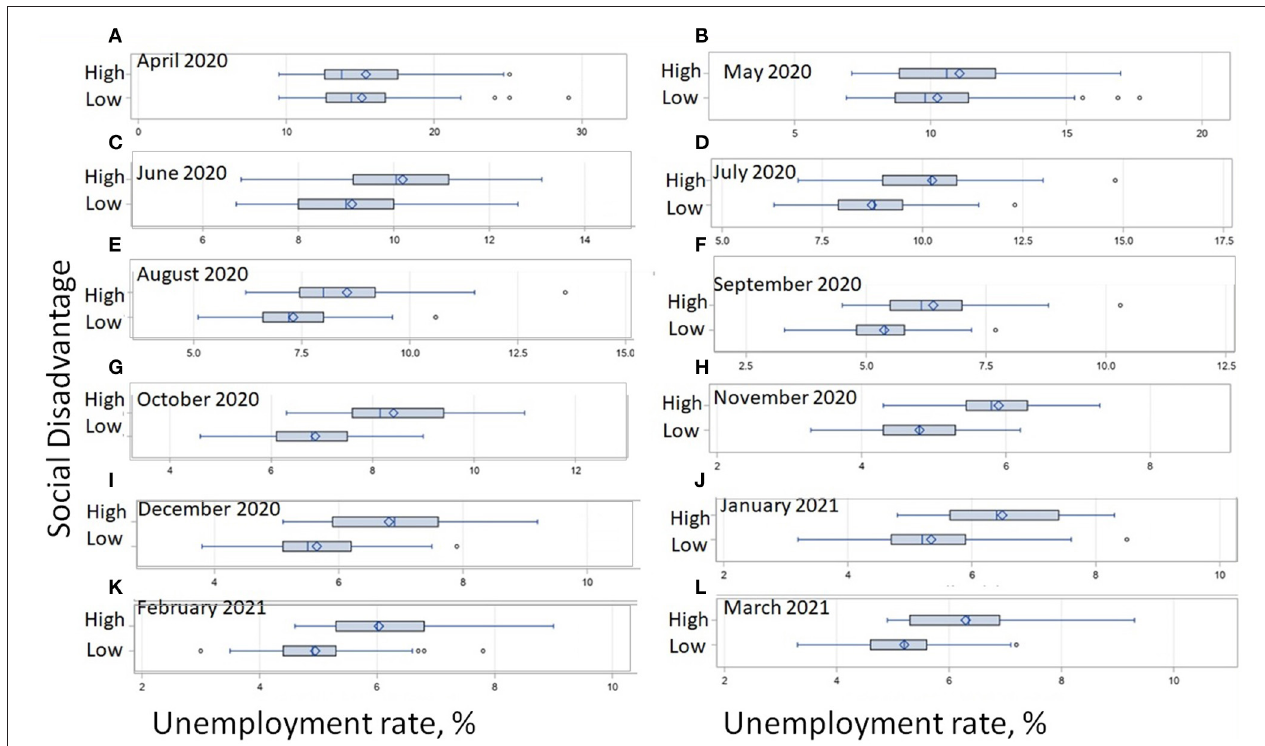
February 2021; (L) March